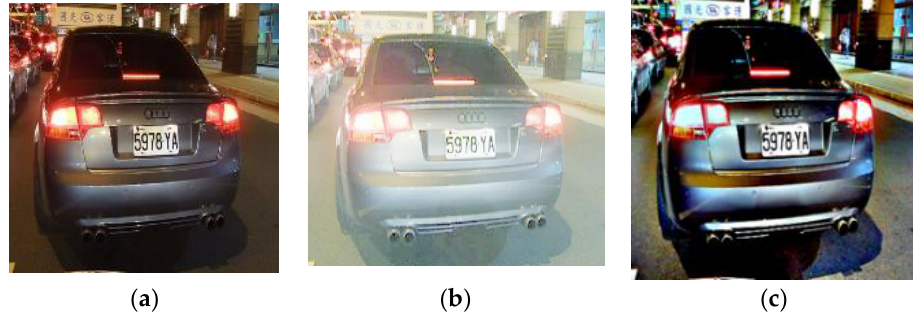
Figure 10. Comparison between different MSR results ( a ) Original, ( b ) Log-based MSR, ( c ) Sigmoid- based MSR.